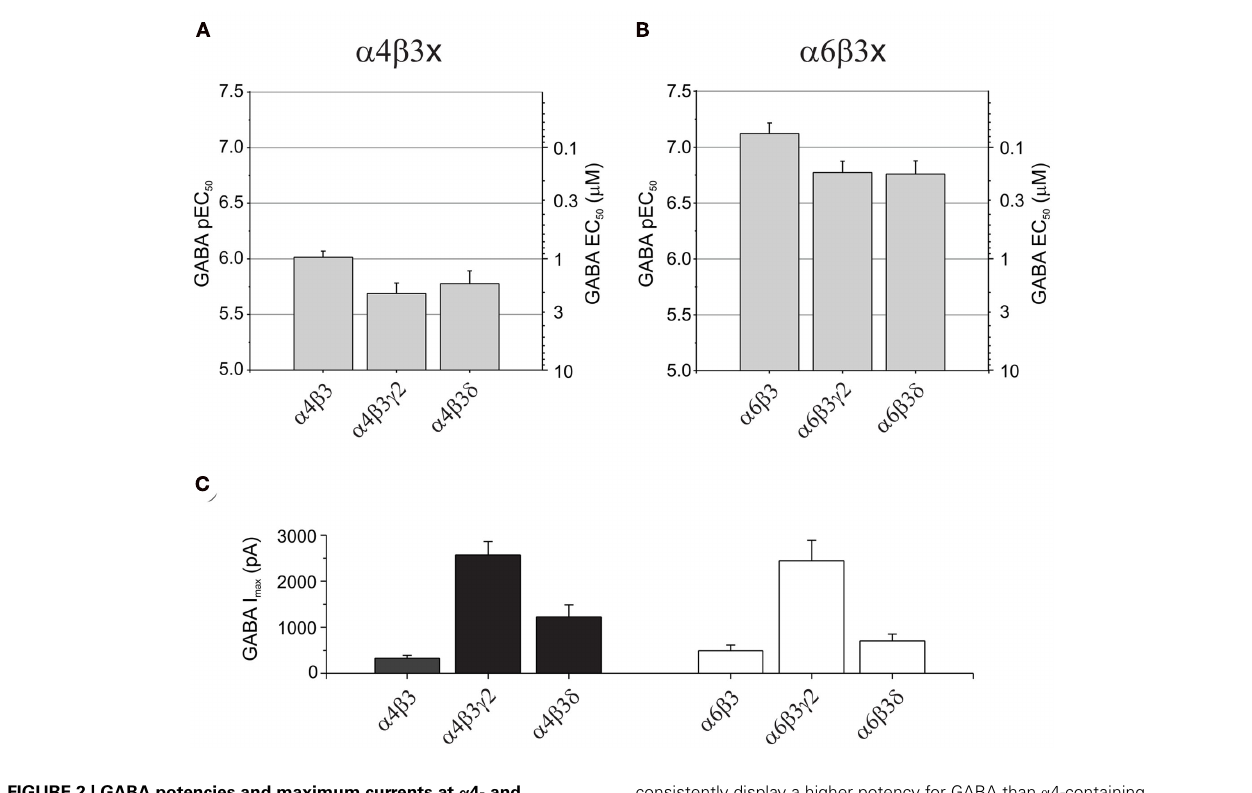
FIGURE 2 | GABA potencies and maximum currents at α 4- and consistently display a higher potency for GABA than α 4-containing α 6-containing GABA ± SEM) receptors. (C) Bar charts of the maximum GABA-induced currents A receptors. Bar charts showing pEC 50 (mean and EC 50 (mean) values for: (A) α 4 β 3, α 4 β 3 γ 2, and α 4 β 3 δ , and (B) α 6 β 3, (mean ± SEM) for α 4- and α 6-containing GABA A receptors expressed in α 6 β 3 γ 2, and α 6 β 3 δ GABA α 6-containing receptors HEK293 cells. A receptors. Note that